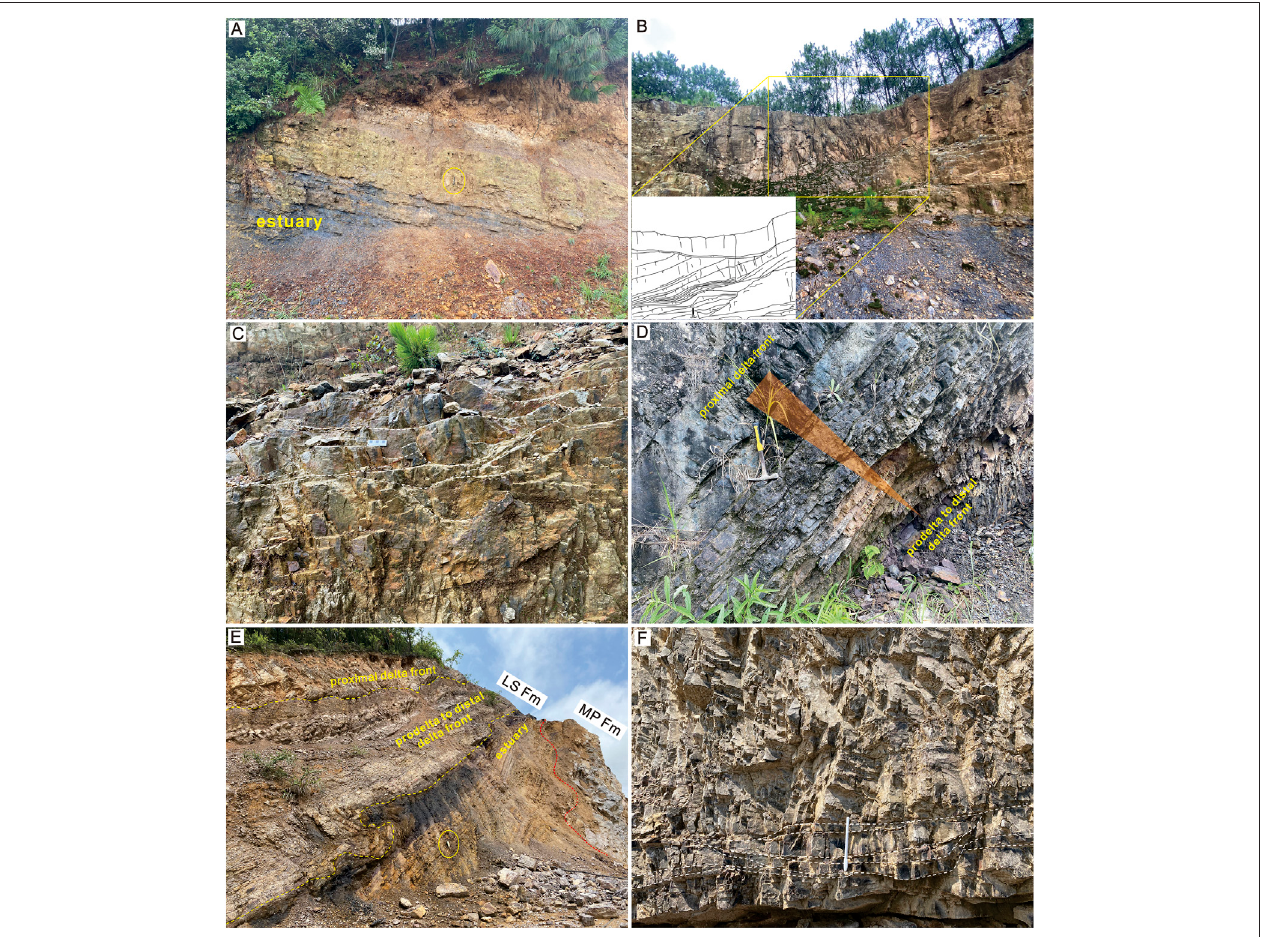
FIGURE 4 | Outcrop photographs of the Liangshan Formation in the Caohai, Houpo, and Mapojiao sections and the facies interpretations. (A) EST facies association at the basal part of Caohai succession, showing a coarsening upward sequence from estuarine bay mudrocks and sandstones to cross-laminated sandstones of the estuarine channel (Pen of 15 cm for scale). (B) Delta distributary channel sandstones in the Caohai section showing lateral accretion macroform overlying on planar bedded fi ne-grained quartzose sandstones of proximal delta front and mudrocks and siltstones of prodelta to distal delta front. (C) Close-up view of trough cross-strati fi ed sandstones of delta distributary channel in the Caohai section. (D) Typical coarsening upward sequence of delta progradation in the Houpo section. (E) DEL and EST facies associations at the lower parts of the Mapojiao section. The distinctive interlamination mudrock and sandstone oftidalrhythmite facies are overlain by interbedded mudrocks and sandstones of prodelta to distal front facies (notebook of ~20 cm, circled, for scale). (F) Close-up view of cross- strati fi ed fi ne-grained sandstones of proximal delta front and delta distributary channel facies in the Mapojiao section.